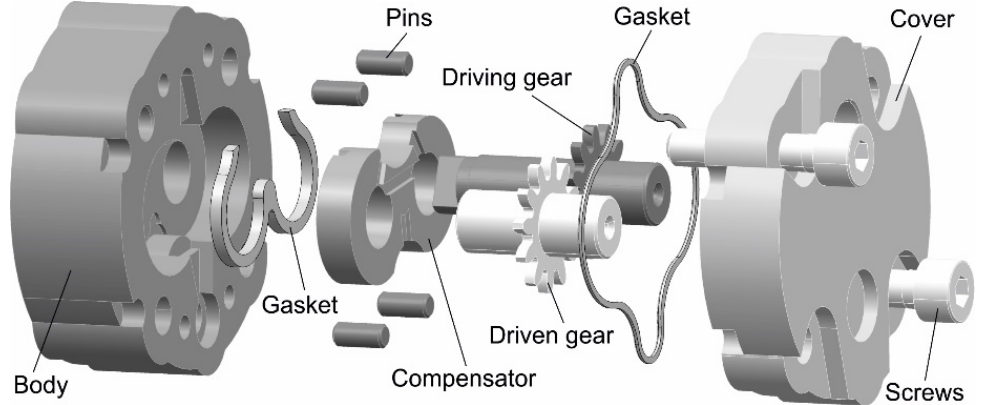
Figure 2. Exploded 3D view of the spur gears pump CAD model.